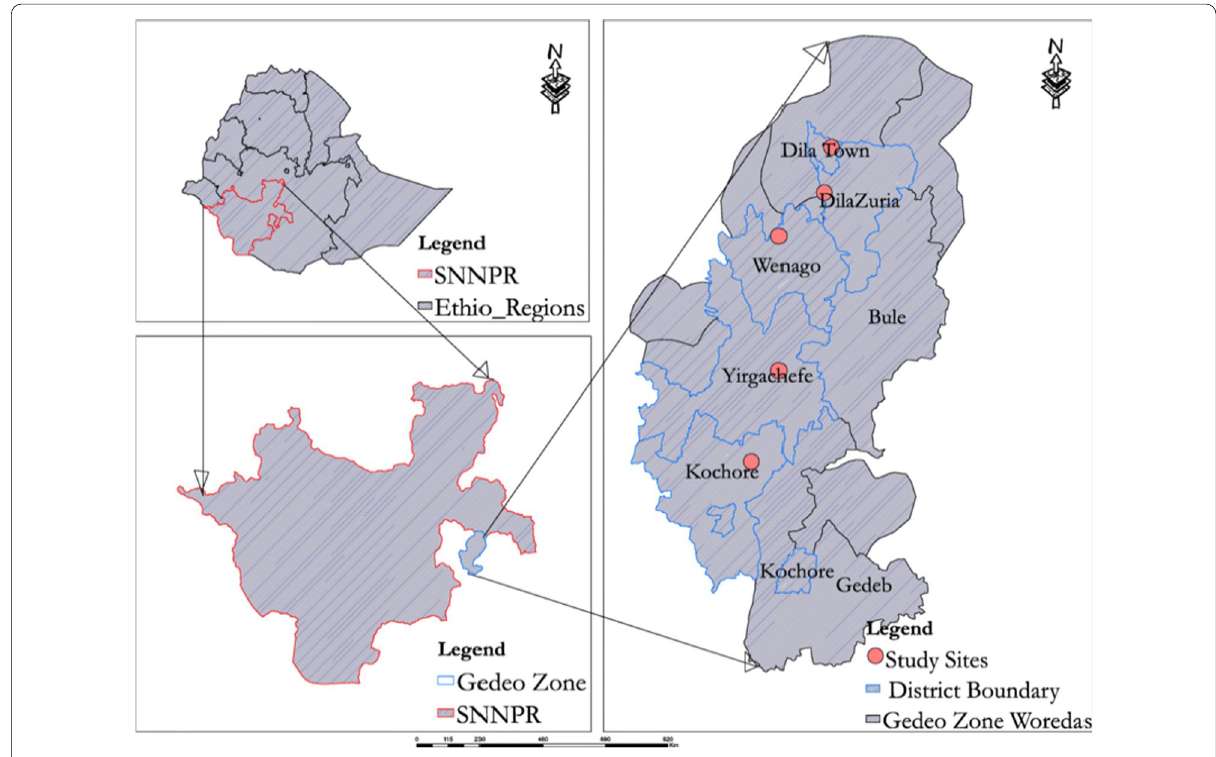
Fig. 1 Map of Gedeo Zone, southern Ethiopia, 2021 (Source: Molla et al. [15])